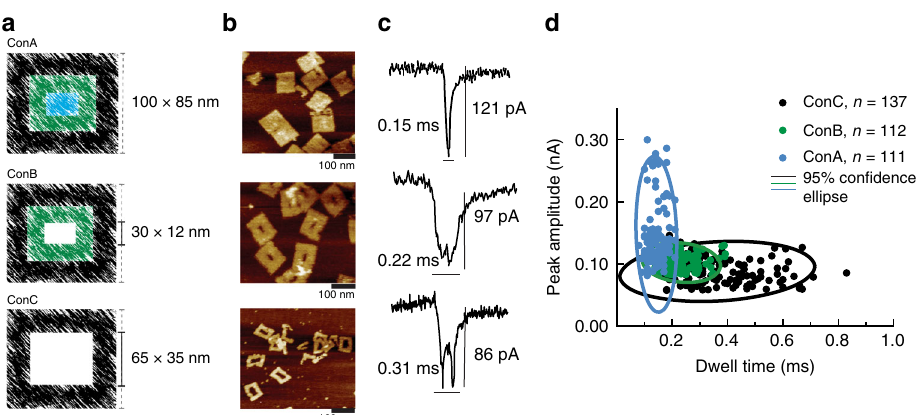
Fig. 1 Concentric square DNA origami nanostructures. a Colour-coded schematic representation of DNA nanostructure designs – ConA is a solid tile and ConB and ConC are frame-like with different central cavities. All three structures feature similar external dimensions but varying internal cavity. b AFM micrographs of the respective nanostructures and c their typical translocation ion current signatures. d Scatter plot of individual translocation events with peak amplitude plotted versus dwell time for ConA (blue circles), ConB (green circles) and ConC (black circles), overlaid with the respective 95% con fi dence ellipses. Source data are in the Source Data fi